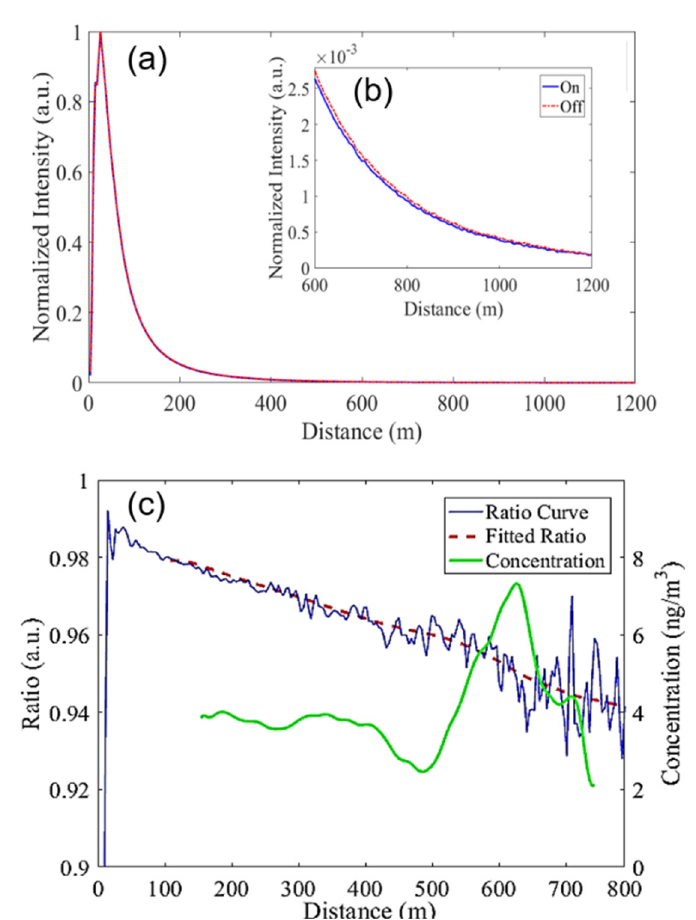
Figure 2. Example of measurement data; ( a ) lidar returns for the on- and off-resonance wavelengths are shown; ( b ) zoom-in of on- and off-resonance curves from 600 to 1200 m; ( c ) DIAL curve, obtained by dividing the on- by the off-resonance lidar returns; fitted ratio and concentration calculated from the DIAL curve. The total data integration time was 5 min, corresponding to 6000 averaged transients and resulting in the range-resolved concentration curve, where the sliding integration interval was about 75 m.